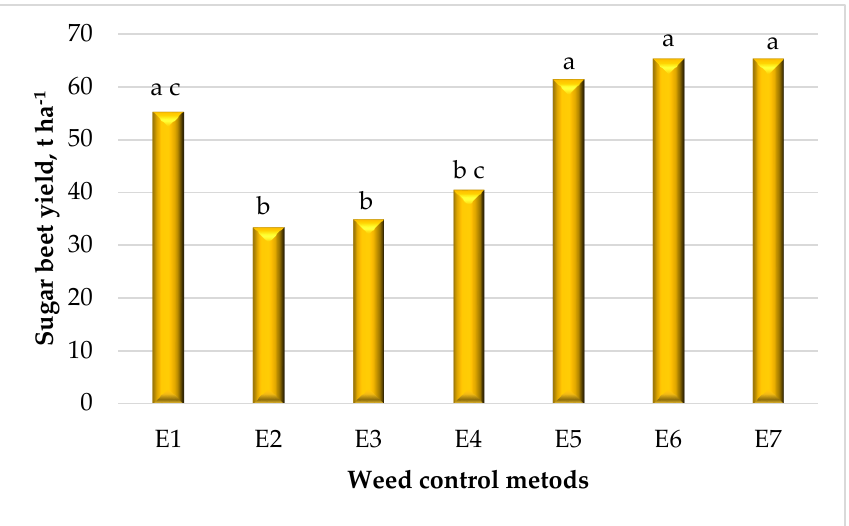
Figure 3. Sugar beet yield in average under different weed control methods.